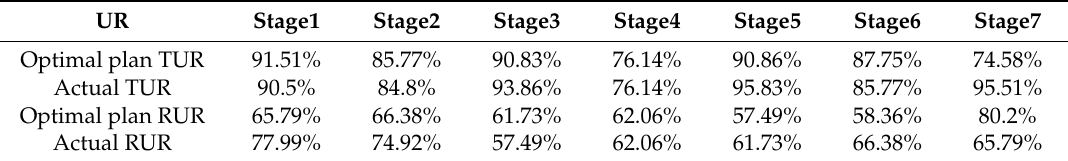
Table 5. Comparison of machinery utilization rate in